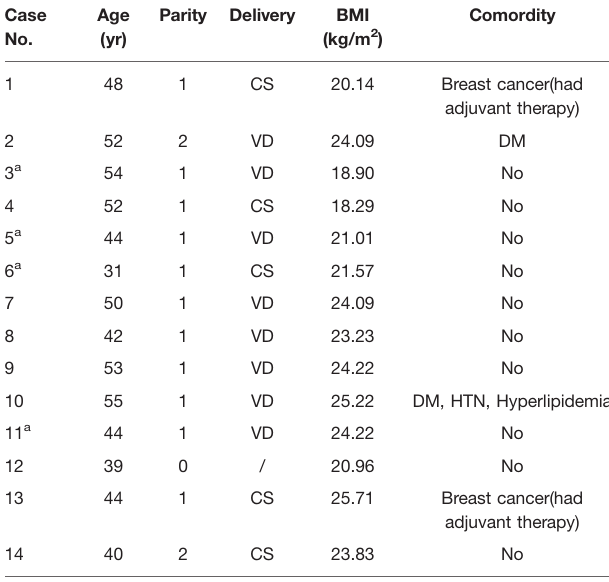
TABLE 1 | Demographic data of